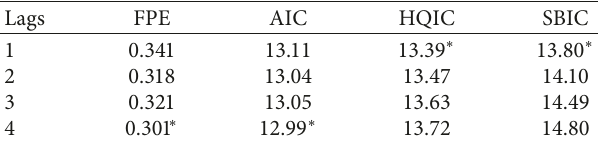
Table 3: Choice of VAR lags.